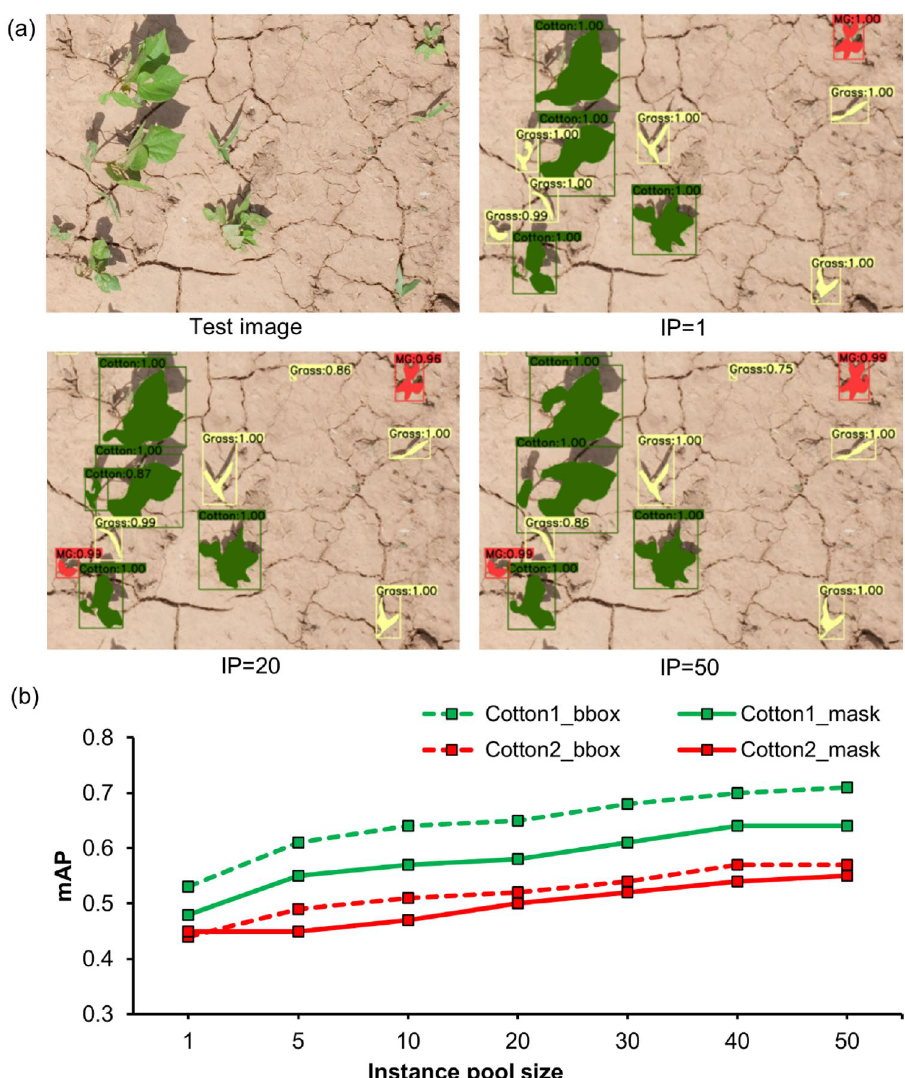
Figure 6. Results obtained from models trained with synthetic images generated using various instance pool (IP) sizes: ( a ) Detection and segmentation results obtained for Cotton1 with IP = 1, IP = 20, and IP = 50, and ( b ) Mean average precision (mAP) values compared for bounding box (bbox) and mask results for Cotton1 and Cotton2, obtained for IP sizes ranging from 1 to 50. Here, green, red, and yellow detected masks represent cotton, morningglories, and grass,